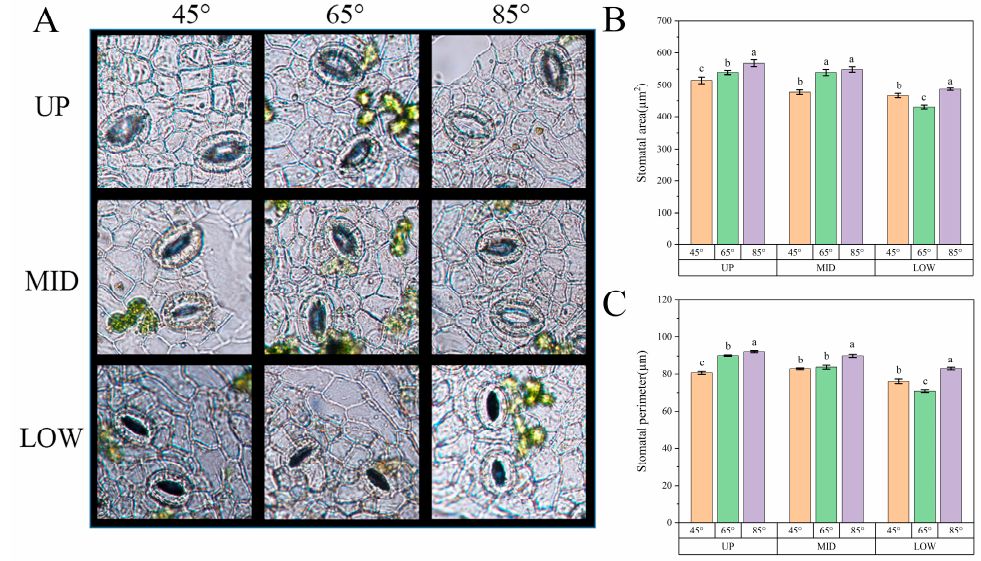
Figure 8. Differences in the stomatal morphology of leaves in different parts of the canopy. ( A ) Stom- Figure 8. Di ff erences in the stomatal morphology of leaves in di ff erent parts of the canopy. ( A ) Sto- atal morphology; ( B ) stomatal circumference; ( C ) stomatal area. Different lowercase letters indicate matal morphology; ( B ) stomatal circumference; ( C ) stomatal area. Di ff erent lowercase le tt ers indi- significant differences between treatments ( p < cate signi fi cant di ff erences between treatments ( p < 0.05).